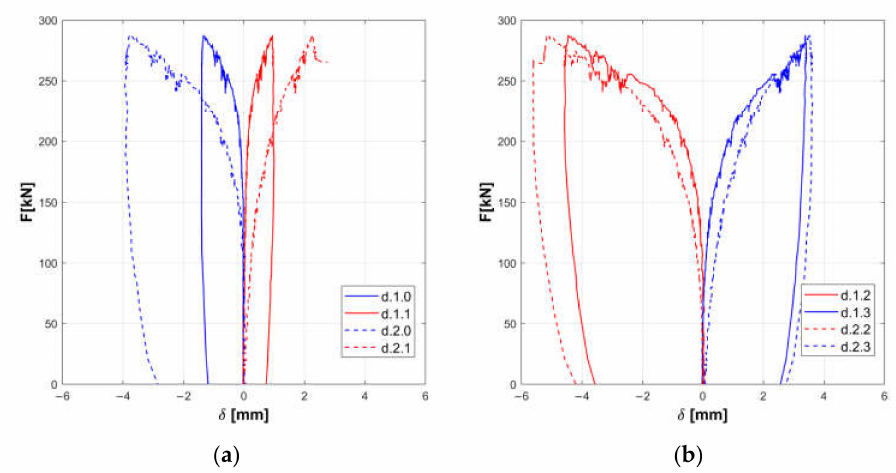
Figure 13. Experimental diagonal displacements of panel C: upper part ( a ) and lower part ( b ). Horizontal displacements are shown in Figures 8, 10 and 12 for the masonry panels A, B, and C, respectively. Diagonal displacements are illustrated in Figures 9, 11 and 13 for masonry panels A, B and C, respectively. In each figure, the results of the shear